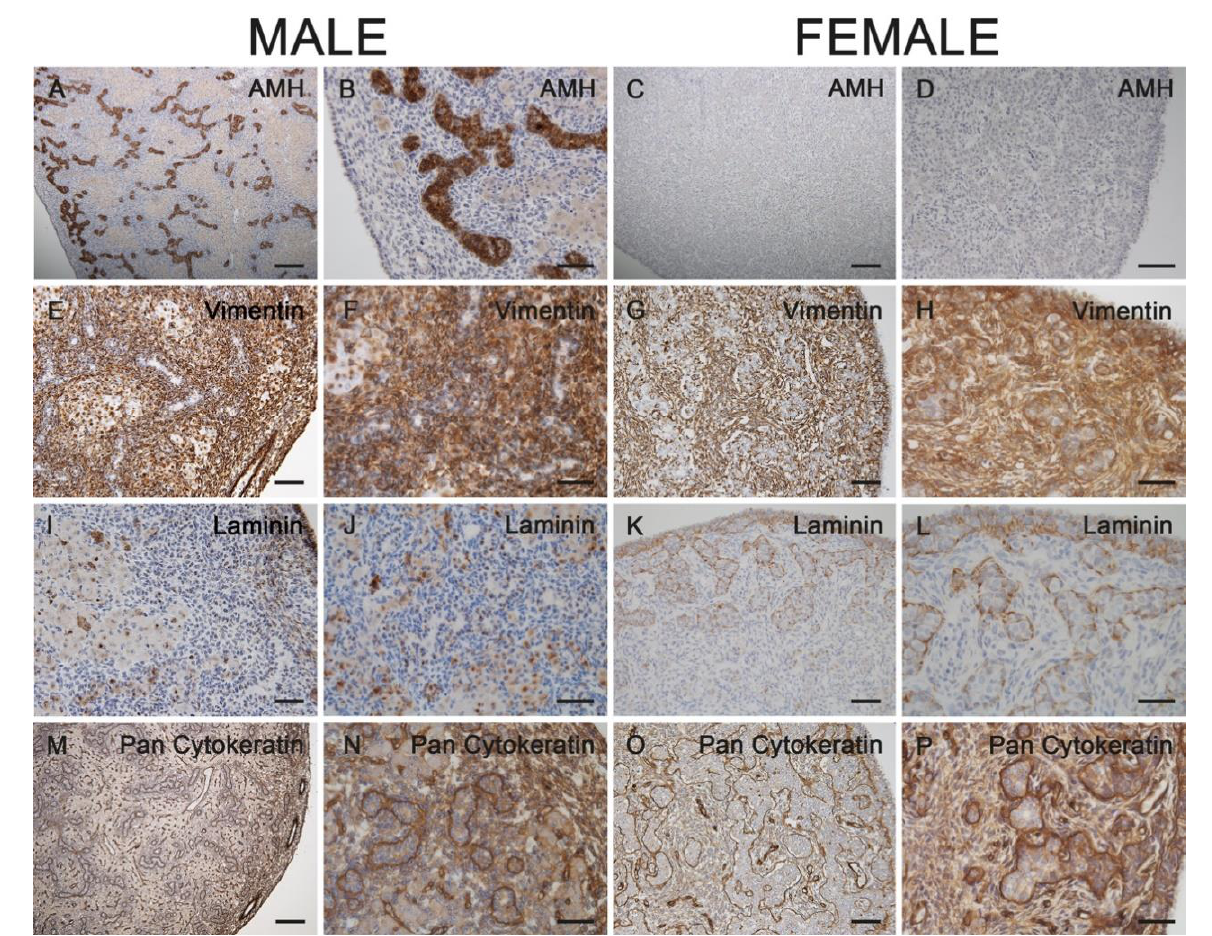
Figure 4. Immunostaining for AMH ( A – D ), vimentin ( E – H ), pan-cytokeratin ( I – L ) and laminin ( M – P ) in male ( A , B , E , F , I , J , M , N ) and female ( C , D , G , H , K , L , O , P ) gonads from 60-day-old horse fetuses. AMH was only expressed in the male fetal testes ( A , B ). Vimentin was expressed in interstitial cells of gonads from both sexes ( E – H ). The surface epithelium of fetal male and female gonads, as well as the cord-like structures in females, stained positive for cytokeratins ( I – L ). A basal lamina-like structure surrounded the developing seminiferous tubules in males and the cord-like structures in females ( M – P ). ( B , D , F , H , J , L , N , P ) represent higher magnifications of their left images. Scale bars for all pictures: 50 µ